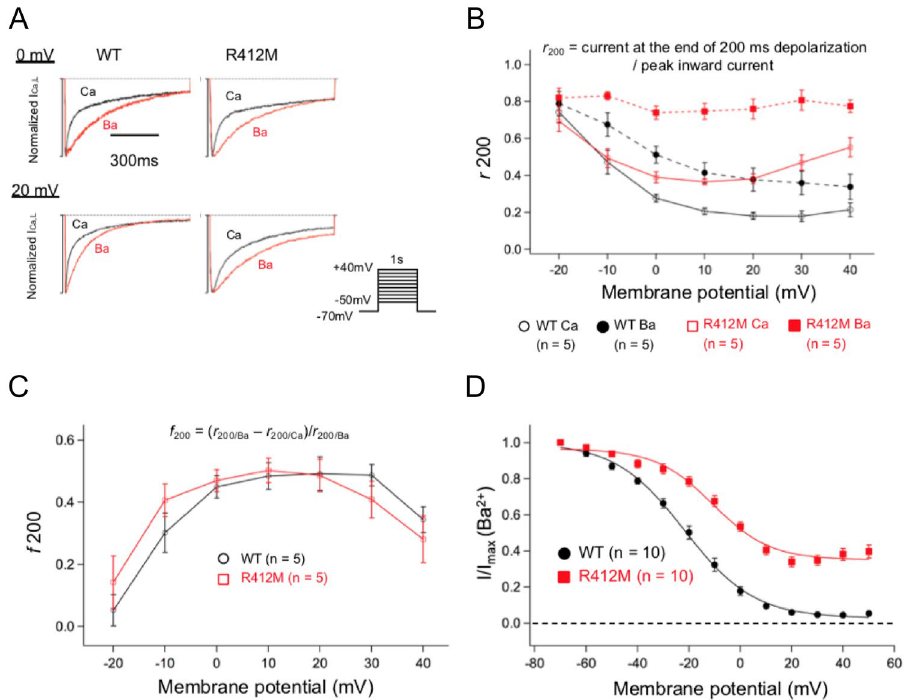
Figure 5. ( A ) Four sets of representative current traces from two different cells expressing either WT (left) or R412M (right) CACNA1C as Ca 2+ (black, I Ca ) or Ba 2+ (red, I Ba ) as a charge carrier at 0 mV (upper panel) and + 20 mV (lower panel). ( B ) Voltage-dependences were evaluated as r 200 ( B ) and f 200 ( C ) at various depolarization for WT (n = 5) and R412M (n = 5) and are plotted as a function of test membrane potentials. ( D ) Using the double pulse protocol as shown in Fig. 4A, the voltage-dependency of I Ba inactivation was examined for WT (filled black circles, n = 10) and R412M (filled red